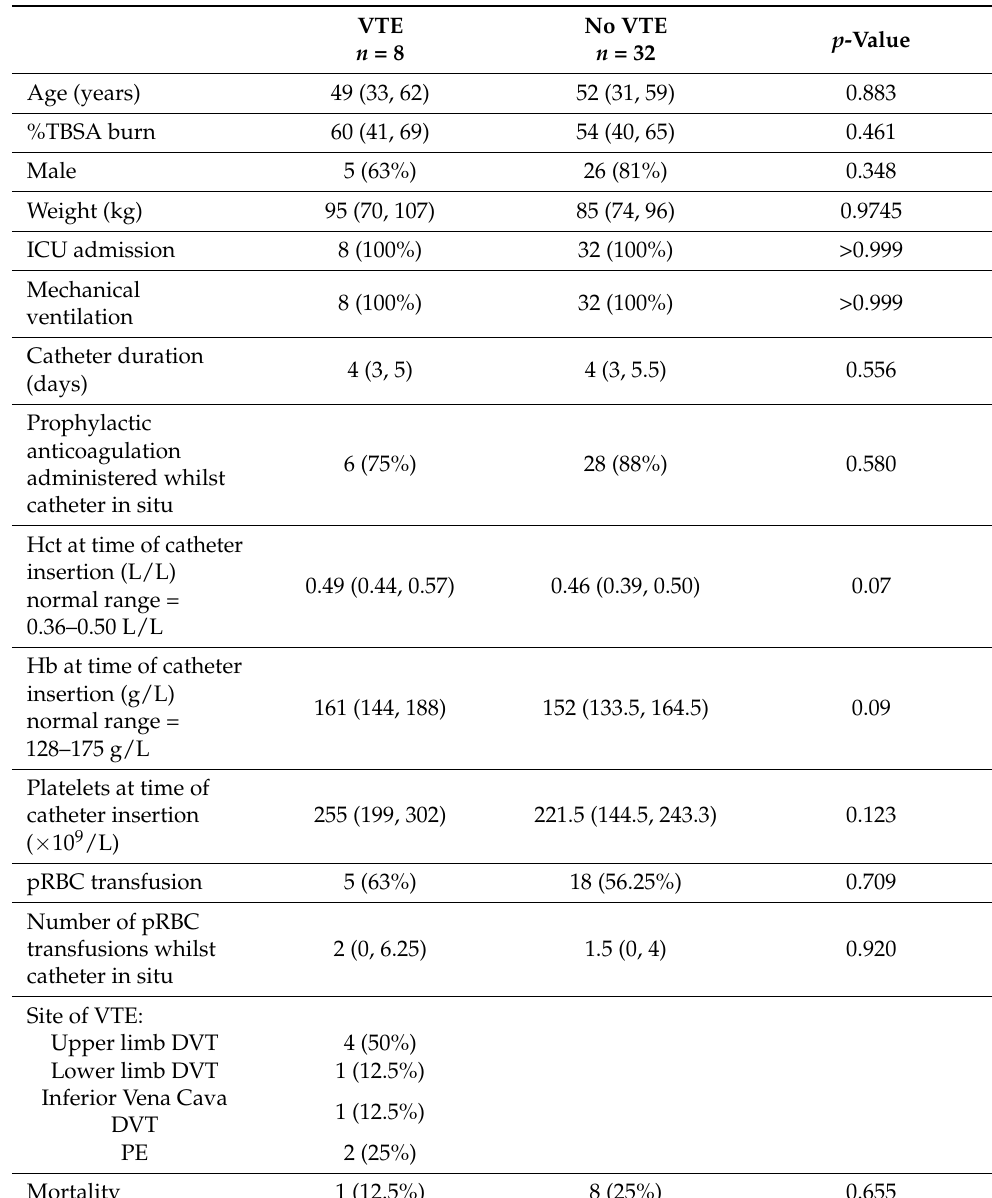
Table 2. Characteristics of patients with total body surface area affected (TBSA) >20% with intravas- cular warming catheter and venous